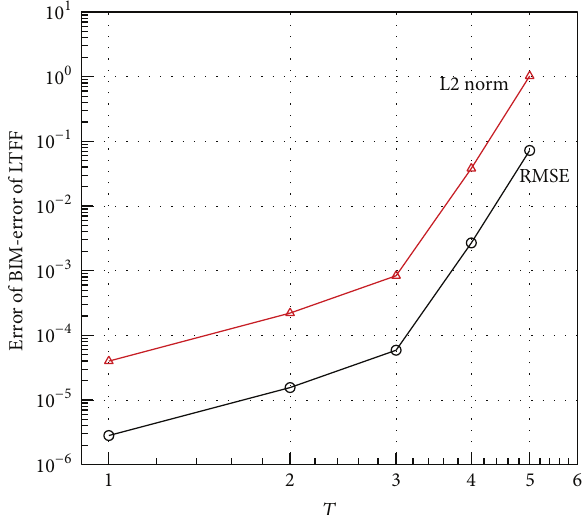
Figure 9: Increasing size of differential error of BIM and LTFF according to final time 𝑇 in the